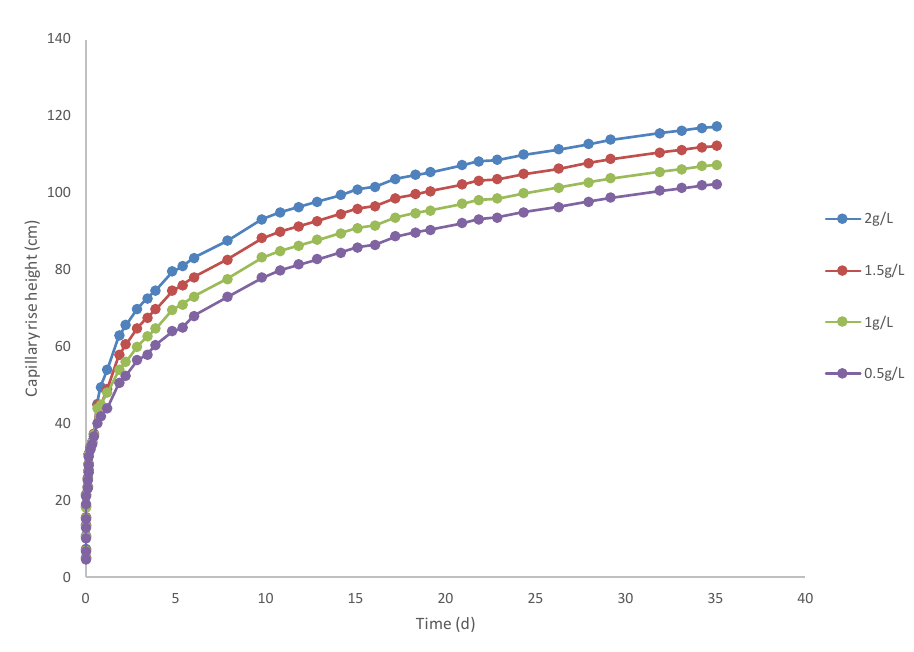
Figure 8. Capillary rising height under different salinity treatments.